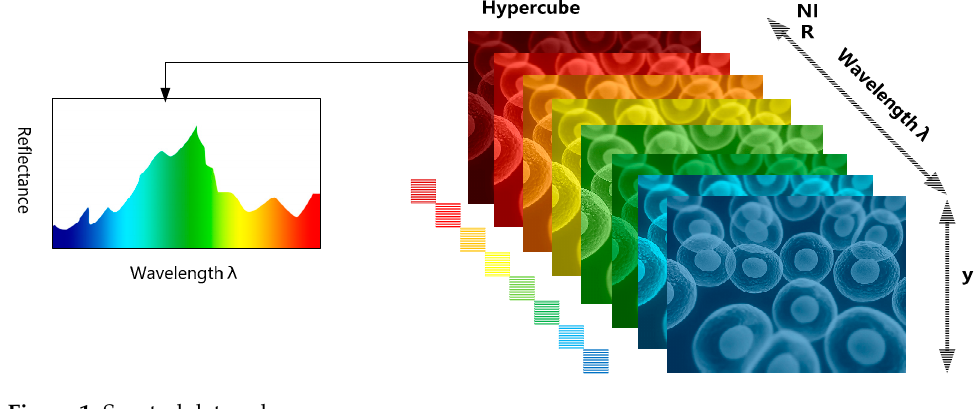
Figure 1. Spectral data cube.